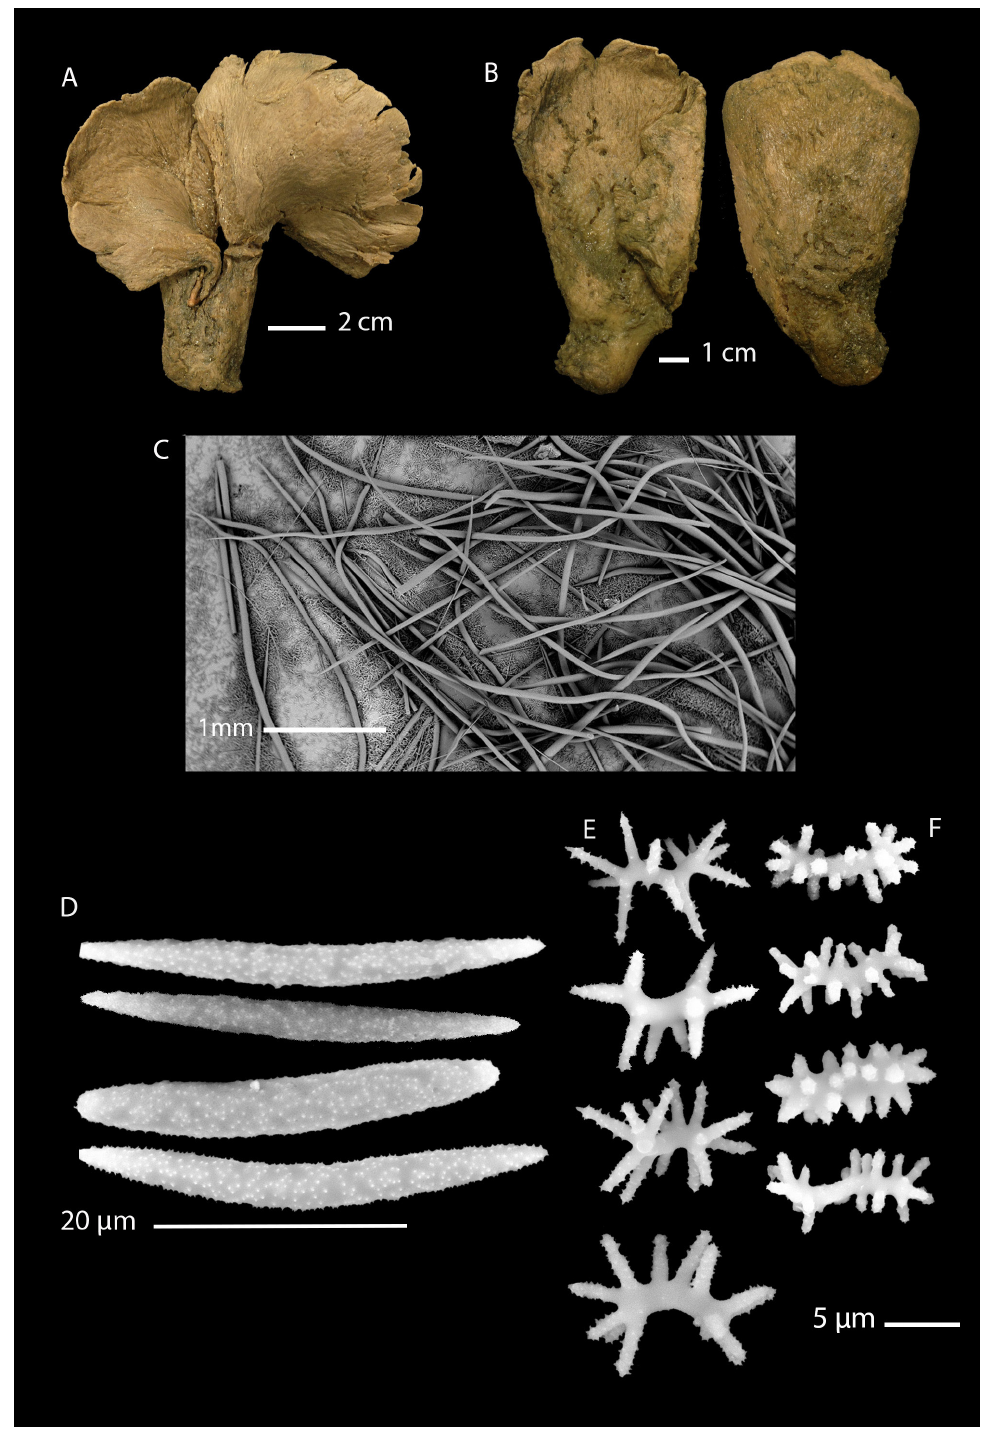
Fig. 3. Morphology, megascleres, and microscleres of Lamellomorpha australis Kelly & Cárdenas sp. nov. A . Bilamellate form (NIWA 89736 leg., holotype). B . Club-shaped morphology showing both sides (NIWA 93483 leg., paratype). C . Sinuous oxeas (NIWA 44388 leg.). D . Curved, roughened microstrongyles (rounded ends) and microxeas (blunt-pointed ends) (NIWA 44388 leg.). E . Metaster- like streptasters with heavily spined, relatively long rays (NIWA 89736 leg. and NIWA 89717 leg.). F . Spirasters with dense, short, microspined rays (NIWA 44388 leg. and NIWA 89736